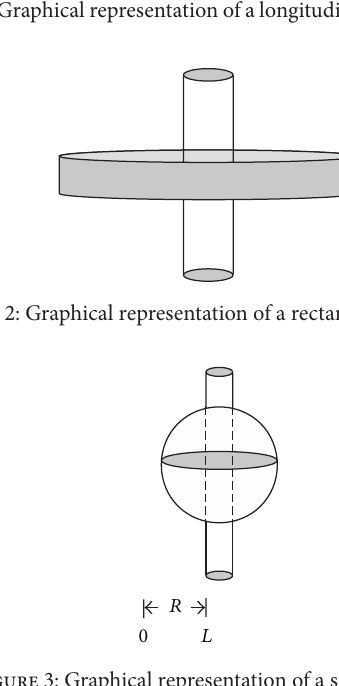
Figure 1: Graphical representation of a longitudinal rectangular fin.